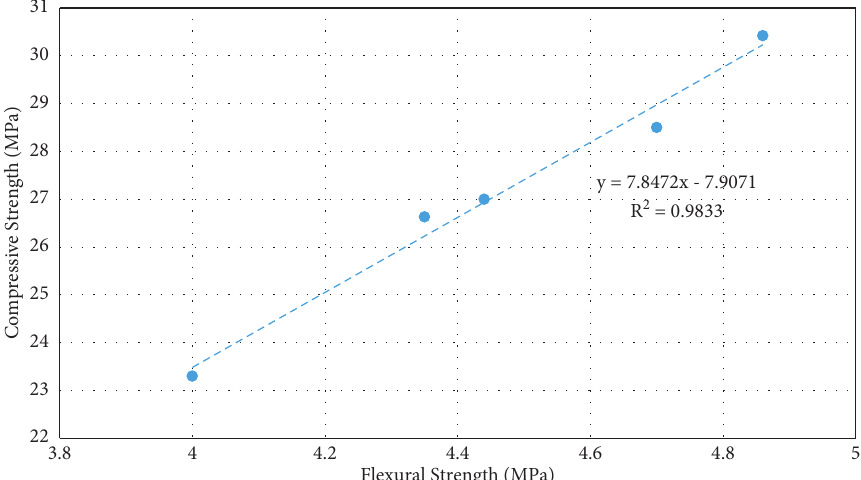
Figure 11: Correlations between compressive strength and flexural strength at 28 days.